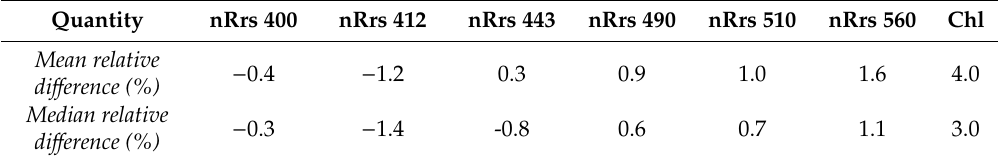
Table 2. Mean and median relative di ff erences (%) between harmonised OLCI-A and OLCI-B L2 water products from L3 comparisons.